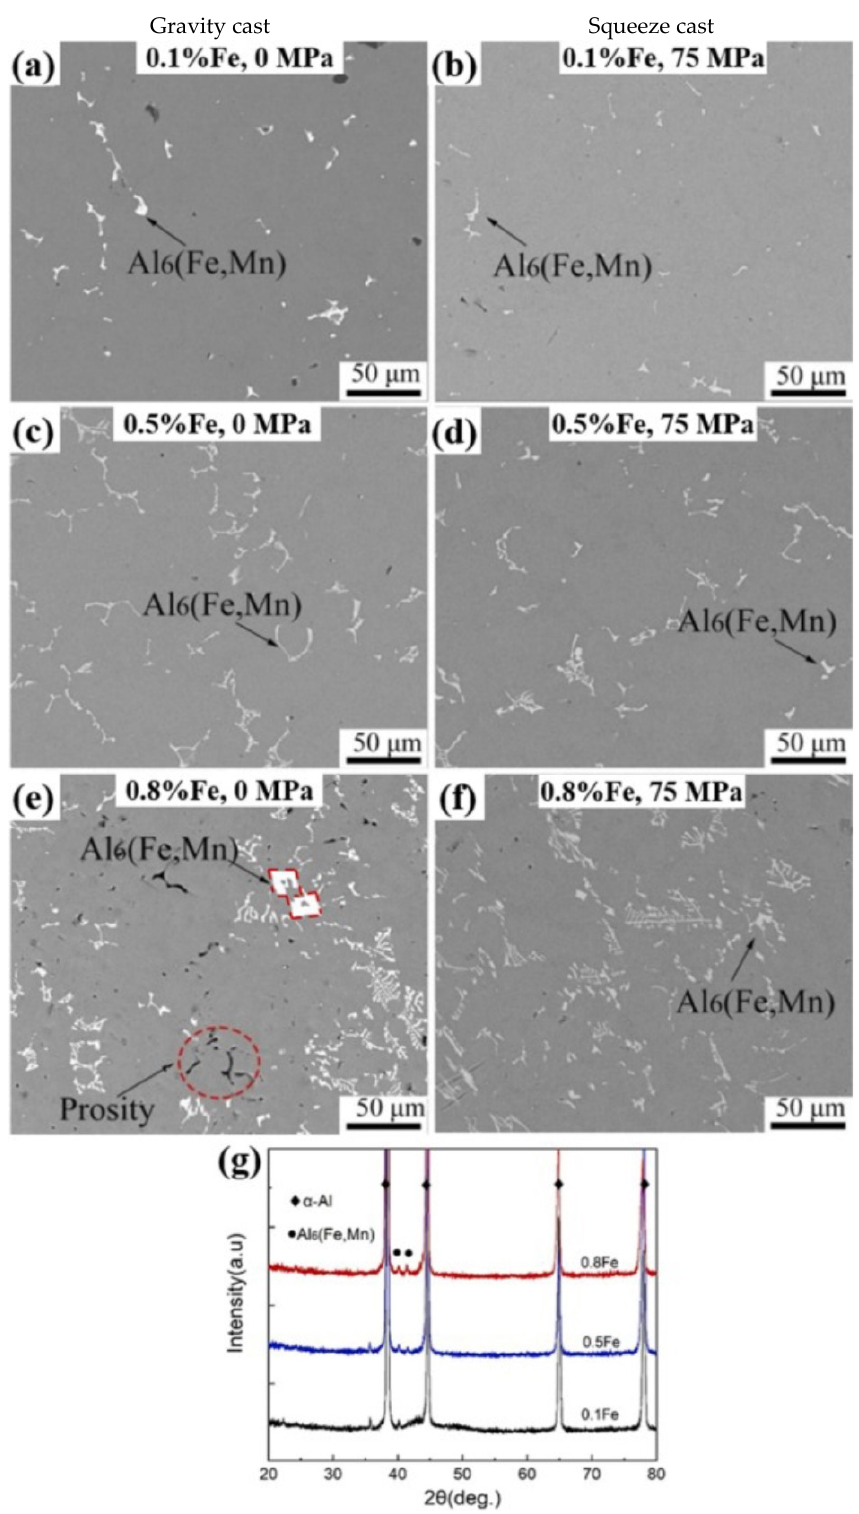
Figure 7. BSE-SEM images of the gravity (0 MPa) and squeeze-cast (75 MPa) AlMg3Mn1(Fe) alloy with different Fe contents—( a , b ) 0.1%; ( c , d ) 0.5%; and ( e , f ) 0.8% Fe. ( g ) XRD spectrum of the gravity- casted alloy. Reproduced from [59] with permission from Elsevier,